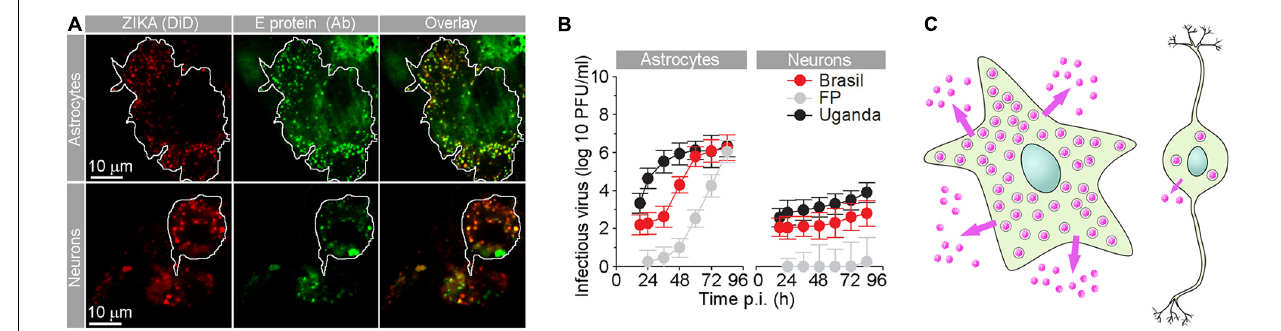
FIGURE 2 | Human fetal astrocytes are more efficiently infected with Zika virus and release more progeny virus than neurons. (A) Micrographs show the internalized fluorescently labeled Brazilian Zika virus (ZIKV) strain in astrocytes and neurons. Prior to infection, Zika virus were labeled by lipophilic Vybrant DiD dye [ZIKA (DiD)], and 36 h post-infection (p.i.), cells were immunolabeled with serum from a patient infected with ZIKV (infected in Brazil in 2016). Overlay panels show remarkable co-localization between vesicular structures with fluorescently labeled ZIKV and anti-ZIKV antibodies from the patient’s serum. The cell boundaries of individual astrocytes and neurons are delineated. Note that the number of Zika particles is significantly higher in astrocytes compared to neurons. (B) The graphs represent plaque assay measurements of infectious virus particles in the supernatants at different times p.i. of three ZIKV strains [Brazil 2016 (Brazil), French Polynesia 2013 (FP), and Uganda #976 1947 (Uganda)]. The production trend of infectious virus particles in astrocytes is higher than that in neurons for all three strains. In both astrocytes and neurons, infectious ZIKV-FP virus particles exhibited the lowest concentrations. At 12 h p.i., the supernatant did not contain countable plaques of ZIKV-FP viral particles. (C) A schematic representation depicting higher production and release of progeny ZIKV virus (pink dots) in astrocytes compared to neurons. Modified from Jorgaˇcevski et al. (2019) with